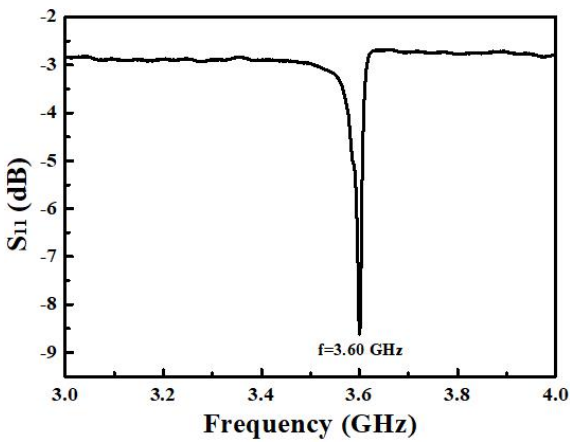
Figure 5. Frequency response of the SMR device with 770 nm AlGaN film as the piezoelectric layer.